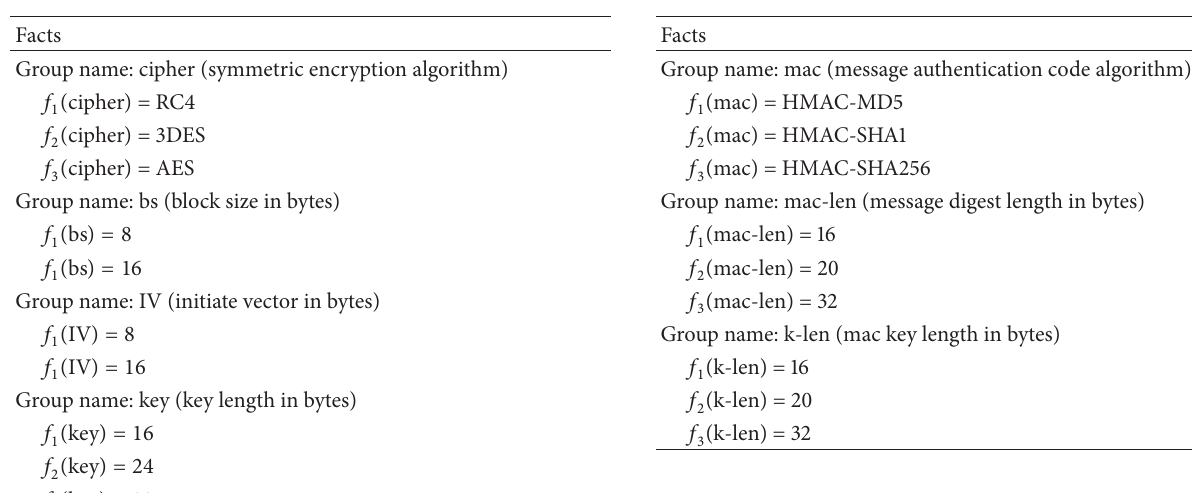
Table 4: The group of facts refers to symmetric encryption. Table 5: The group of facts refers to message